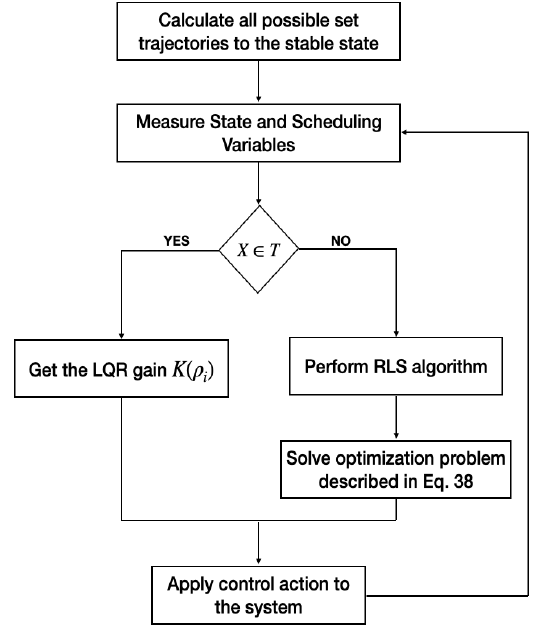
Figure 4. Flow diagram of the LPV-MPC-LQR control strategy.